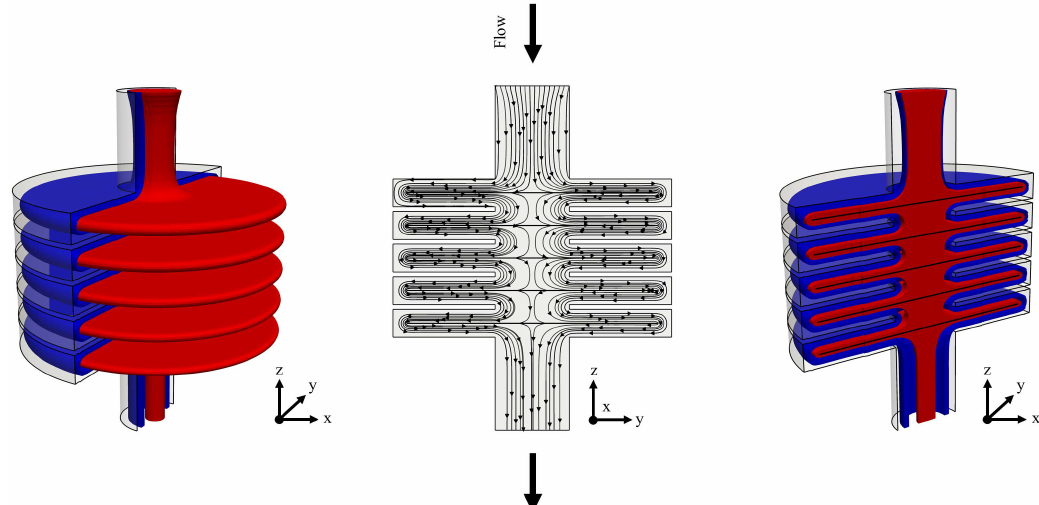
Figure A5. 3-D flow domain and flow pathlines in the CSFO micromixer. Fluid overlapping flow profile ( left and right ) and flow pathlines between inlet and outlet on the central plane of the CSFO design ( center ). Red and blue colors show the fluids injected from core and outer inlets, respectively.